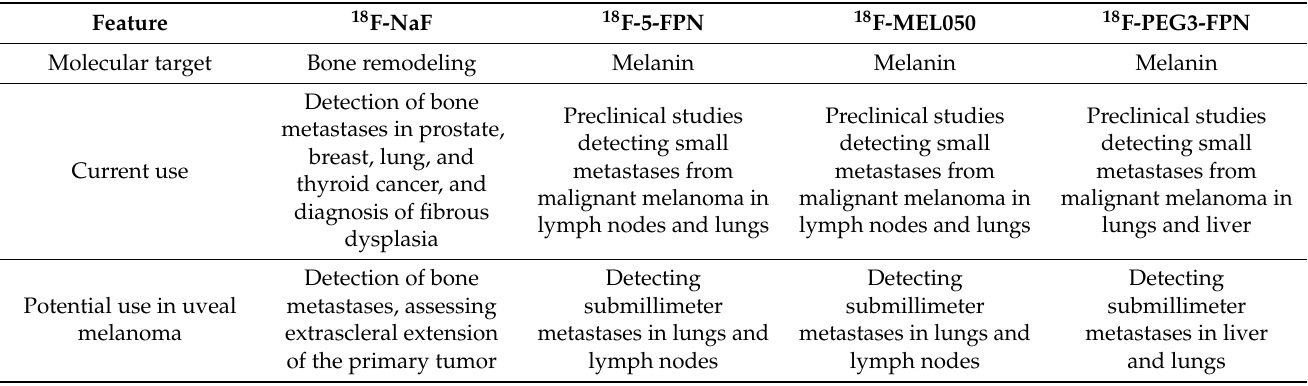
Table 2. Radiopharmaceuticals for PET imaging with potential for use in uveal melanoma